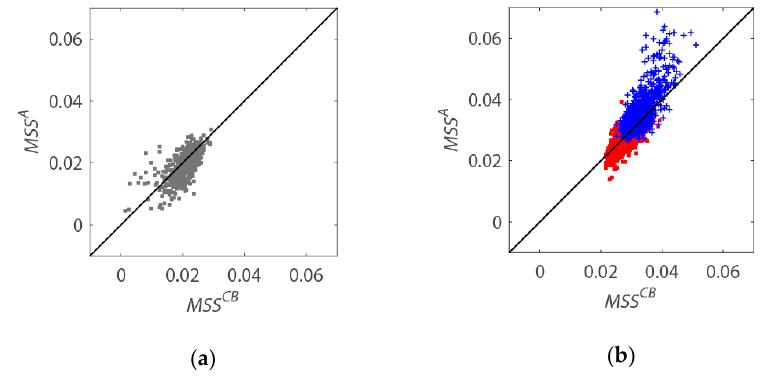
Figure 7. Buoy (cid:1839)(cid:1845)(cid:1845) (cid:3004)(cid:3003) and altimeter (cid:1839)(cid:1845)(cid:1845) (cid:3002) when the wind speed is lower ( a ) or higher ( b ) than 5 m·s − 1 . In the right-hand panel, the blue (red) plots indicate data for the case in which the wind speed is higher (lower) than 10 m·s − 1 .